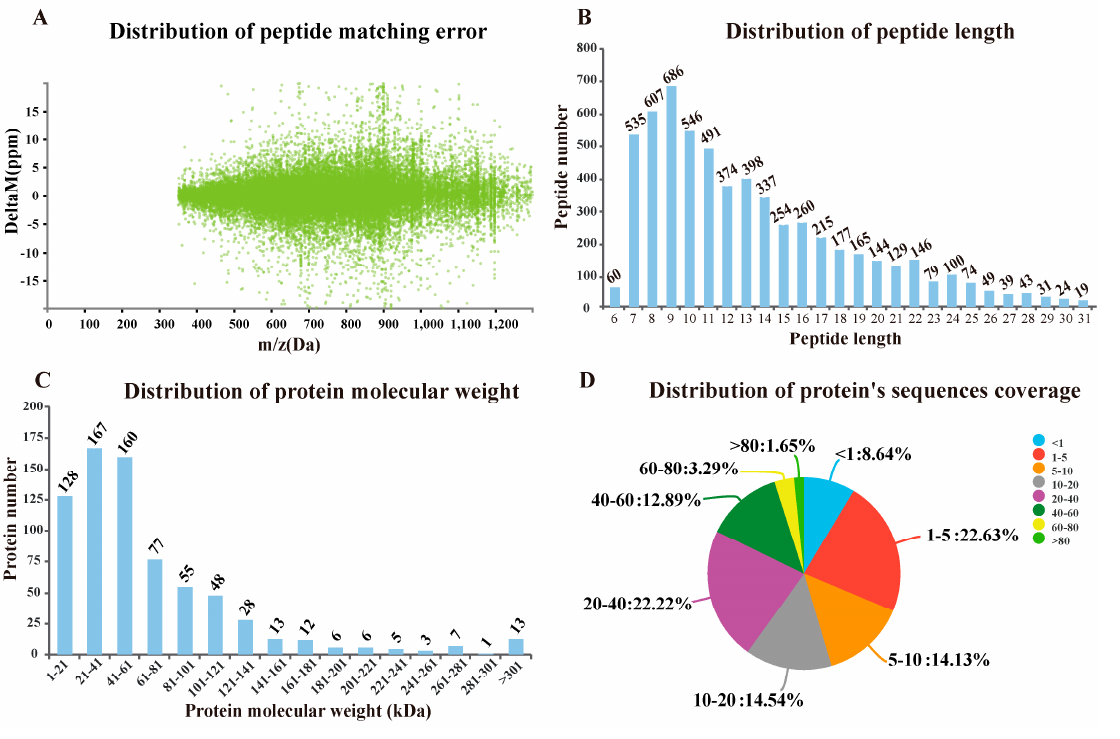
Figure 2. Serum IFN- γ and IL-4. Hu sheep were i.m. immunized twice at a 3-week interval with FMD vaccine emulsified with SO-VE-GS (n = 10) or ISA 206 (n = 9), and sheep without immunization served as a control (n = 10). Blood samples were collected at 8 weeks post the booster for analysis of IFN- γ ( A ) and IL-4 ( B ). The values are presented as mean ± SE. Bars with different letters are